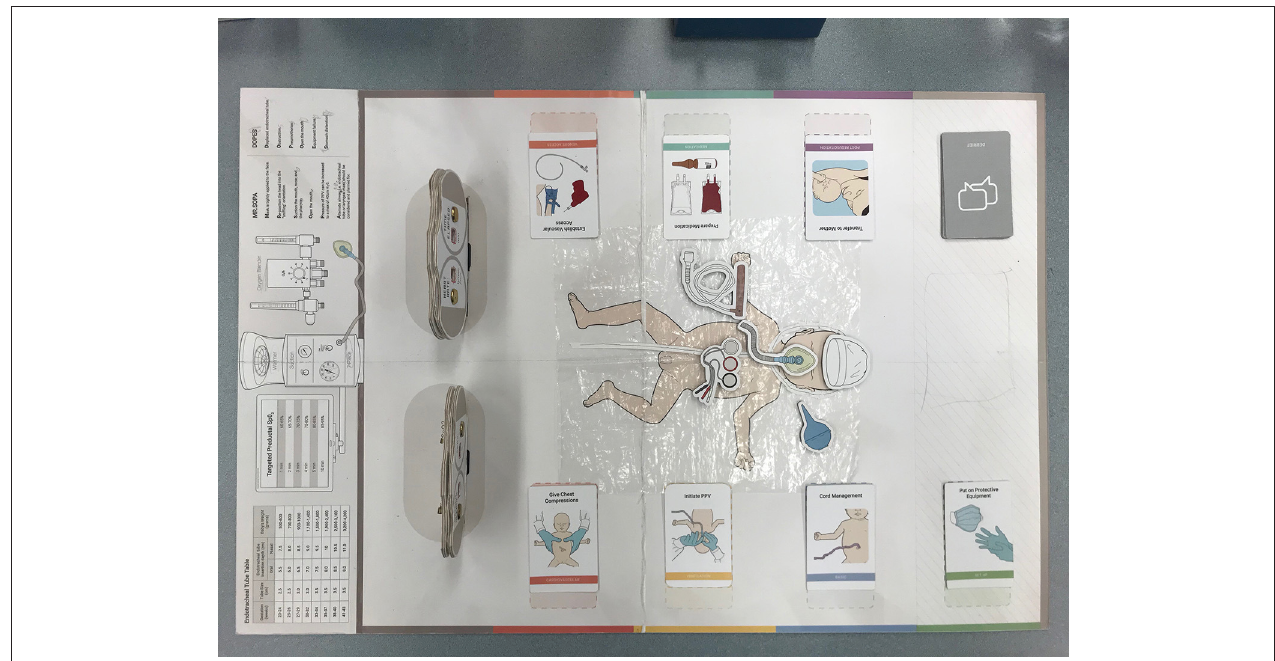
Frontiers in Pediatrics |